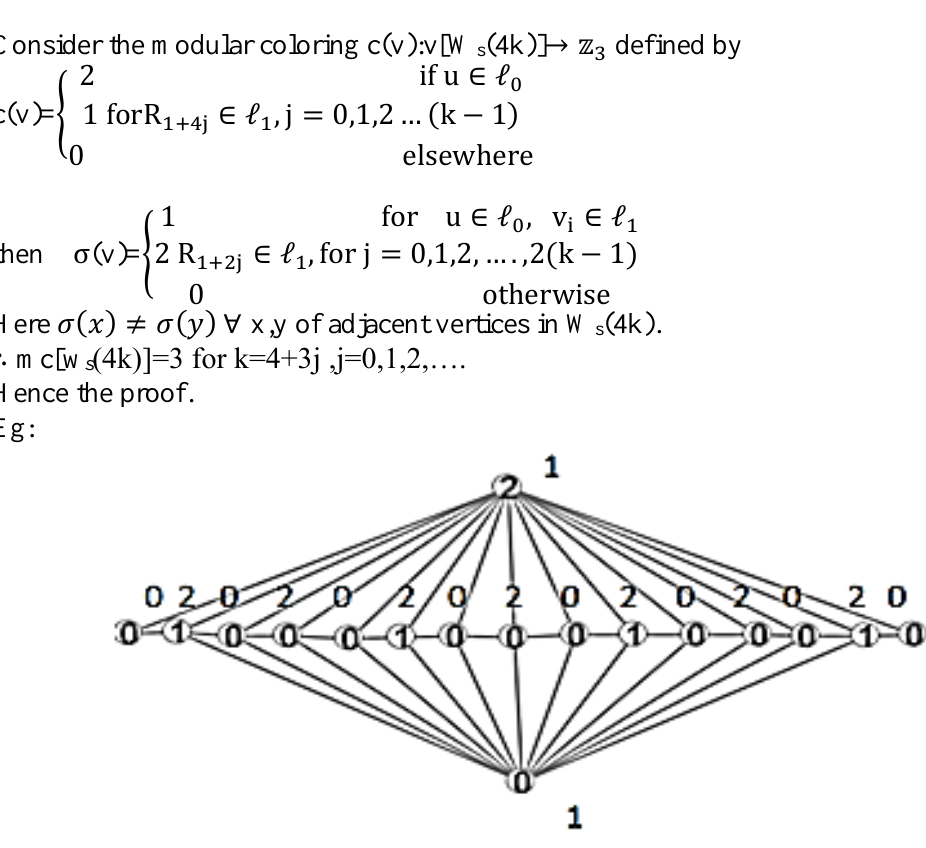
Figure7 . Switching with modular coloring in